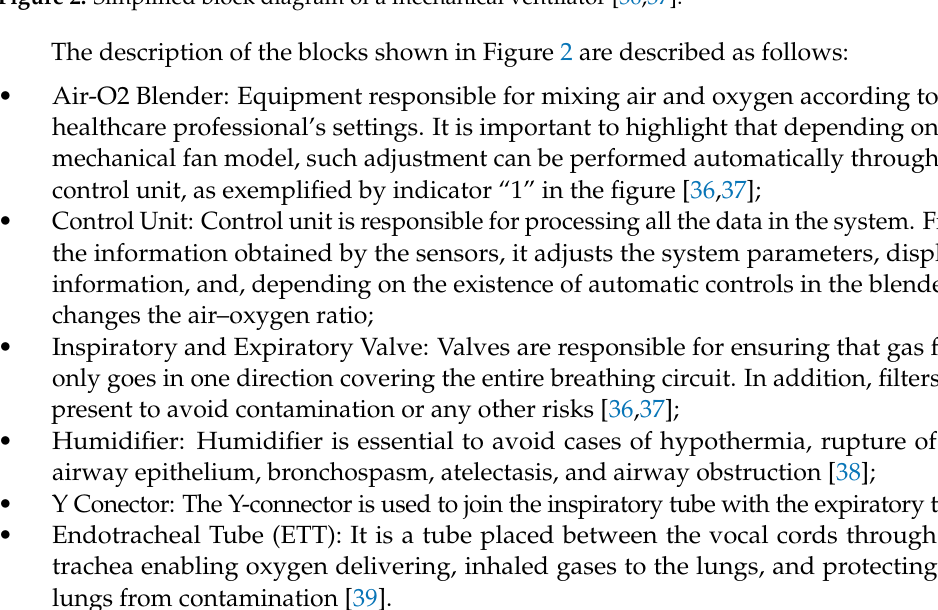
Figure 2. Simplified block diagram of a mechanical ventilator